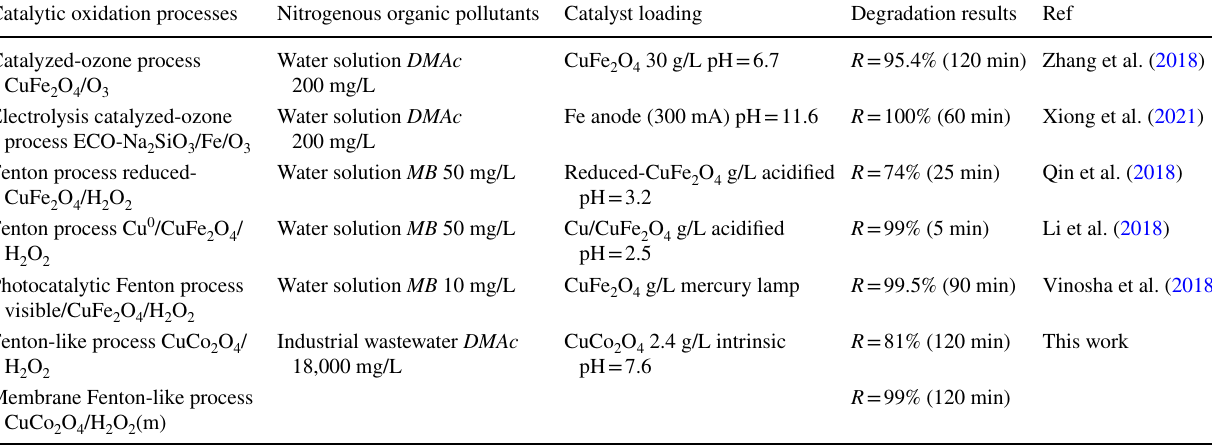
Table 3 Comparison of the literature and this work on degradation rate of nitrogenous organic pollutants (DMAc or MB) in water with various catalytic oxidation processes (DMAc: N , N -dimethylacetamide and MB: methylene